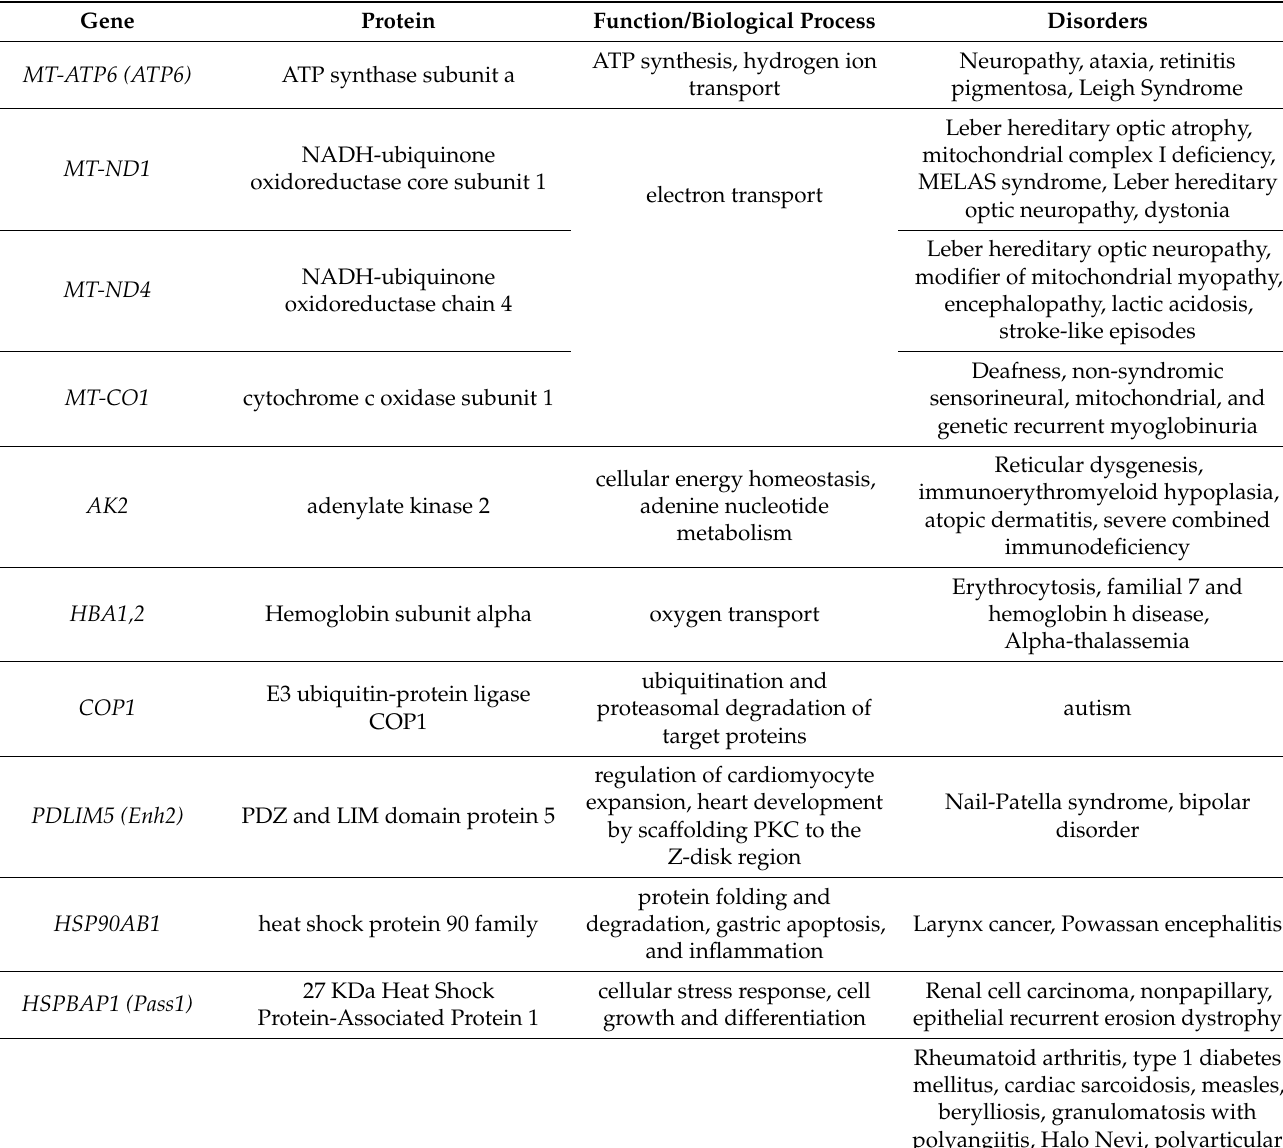
Table 1. Genes and proteins involved in the pathogenesis of various diseases, the expression of which is regulated by the EW